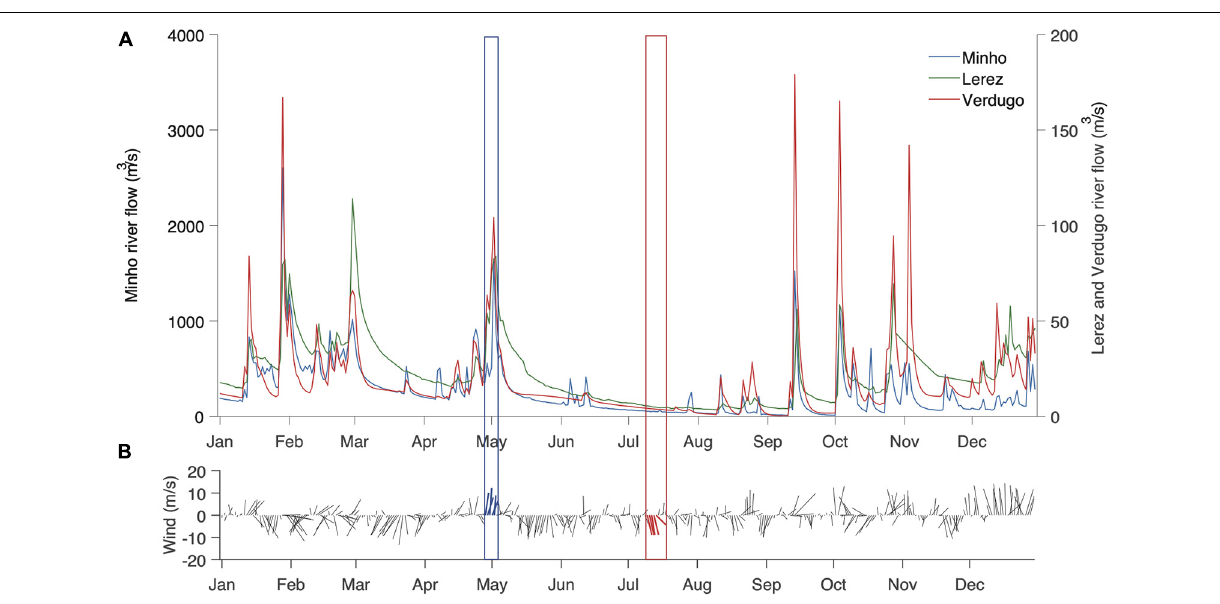
FIGURE 3 | Time series of (A) rivers flow (m 3 /s) for Minho (blue), Lérez (green), and Oitavén-Verdugo (red) rivers with corresponding scales on both sides for Minho river at the left and for Lérez and Oitavén-Verdugo rivers at the right side. (B) Stickplot of daily mean wind directions and intensities (m/s): positives values indicate southerly winds (downwelling favorable winds), and negative values indicate northerly winds (upwelling favorable winds). Blue/red boxes and vectors represent the downwelling/upwelling events